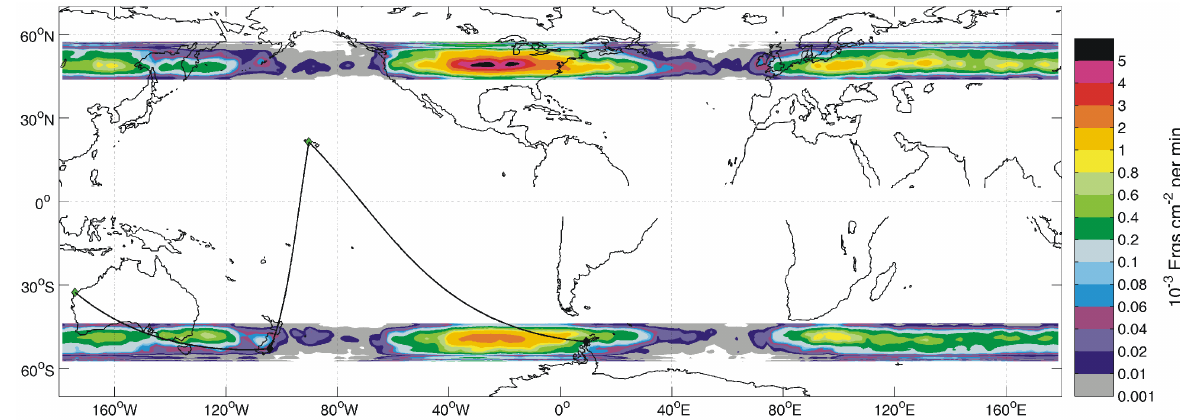
Fig. 7. Map showing the expected global distribution in the rate of energy deposited by WEP into the atmosphere, in the same form as Fig. 3.